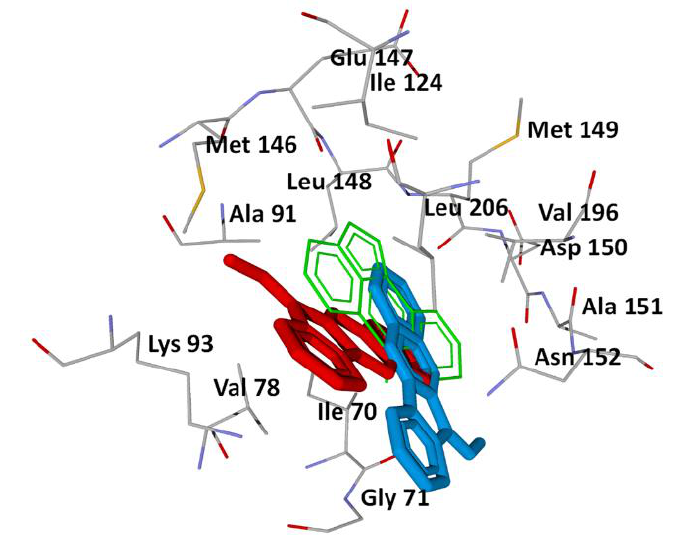
Figure 2. Docking poses of ( Z )- IQ-1 (blue) and ( E )- IQ-1 (red) into the JNK3 binding site (PDB: 1PMV). The co-crystallized ligand SP600125 is shown in thin green lines. Residues within 5 Å from SP600125 are visible.